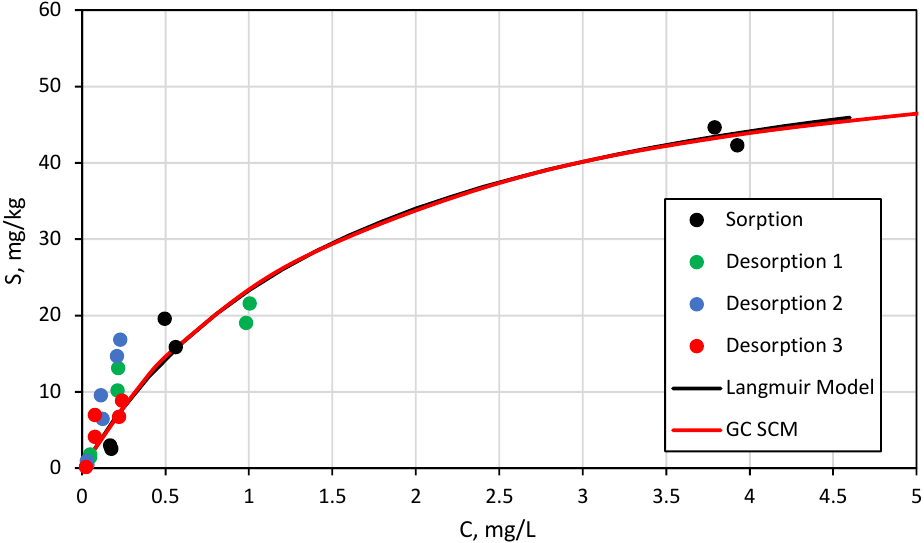
Figure 3. Sorption and desorption results for the CK-6 oolitic chalk. Symbols for desorption steps 1, 2, and 3 and the solid curves for GC SCM and Langmuir isotherm fits to the data are identical to those used in Figures 1 and 2 above.